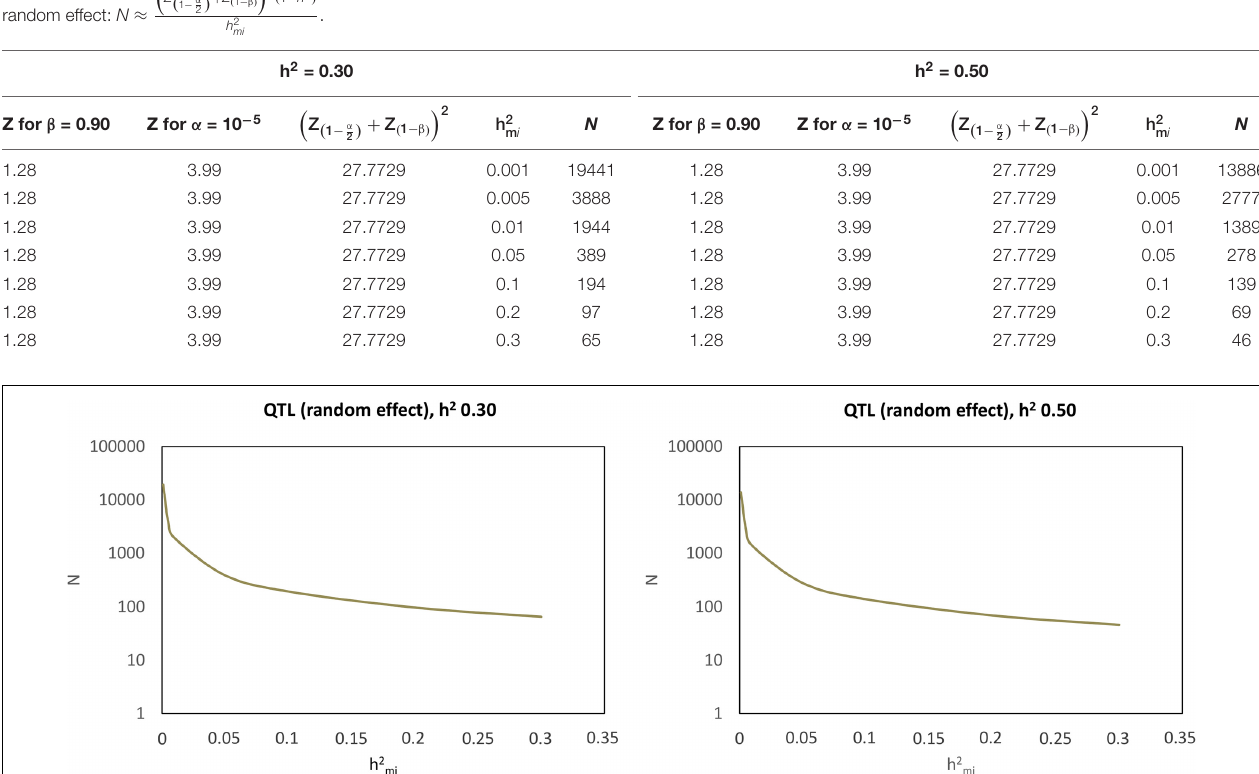
TABLE 2 | Sample size ( N ) and power for detection of significance level 10 − 5 according to the h 2 mi magnitude of the quantitative trait locus, considered as having a